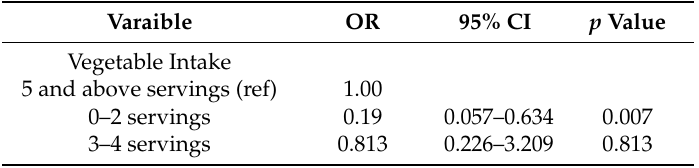
Table 4. Associations between home availability and intake of traditional vegetables.